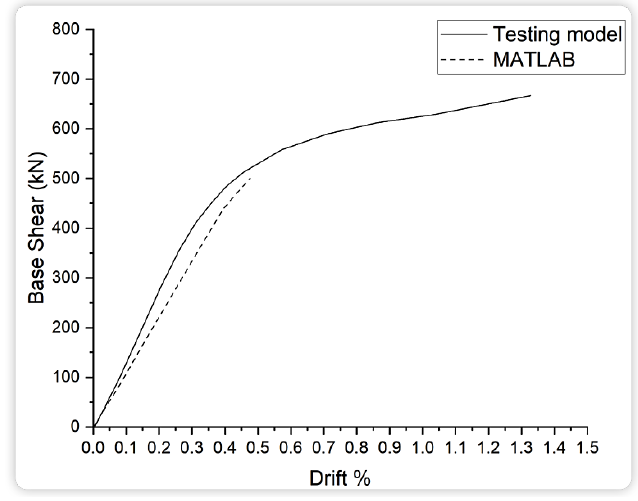
Figure 6. Comparison of numerical (MATLAB) and testing model results.